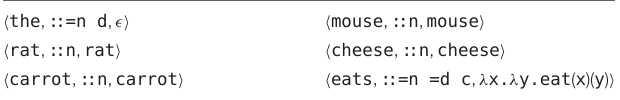
TABLE 9 | Learned minimalist lexicon X 3 at time t =